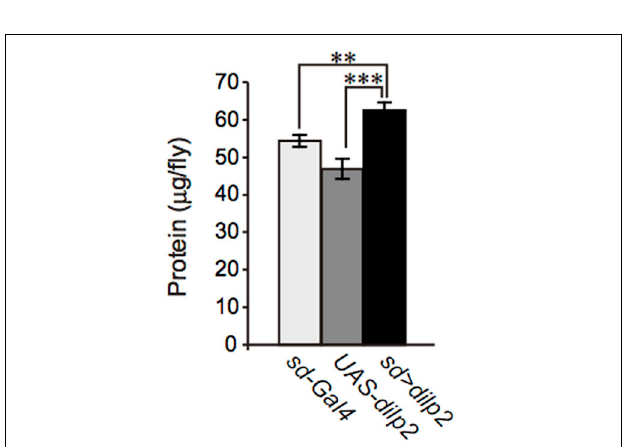
brummer ( dob ), brummer ( bmm ), CG5966 , and CG11055 (B) . Results are shown as the mean ± SE of at least three experiments. ANOVA with Tukeys HSD was performed to analyze statistical significance. ∗ p < 0 . 01.